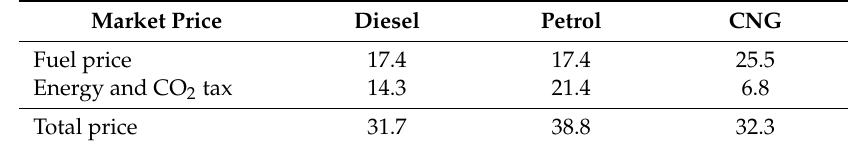
Table 4. Market price (2017) of diesel, petrol and compressed natural gas (CNG) excl. VAT ( € /GJ)